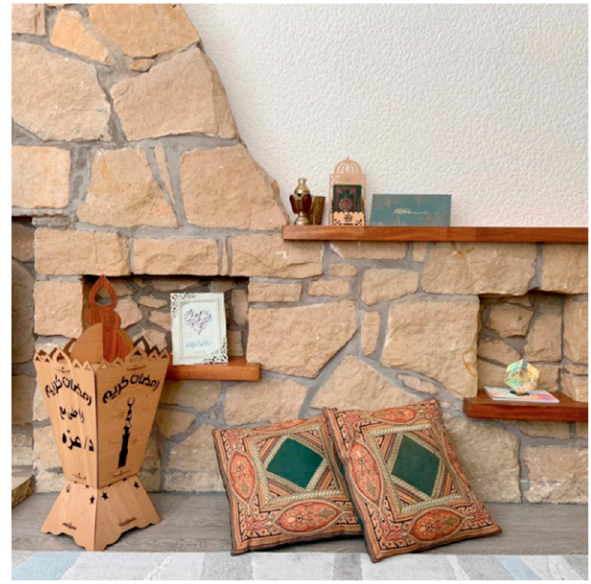
Figure 3. Sumayya’s bedroom Ramadan corner (Sumayya, Diary Image, Entry 1).